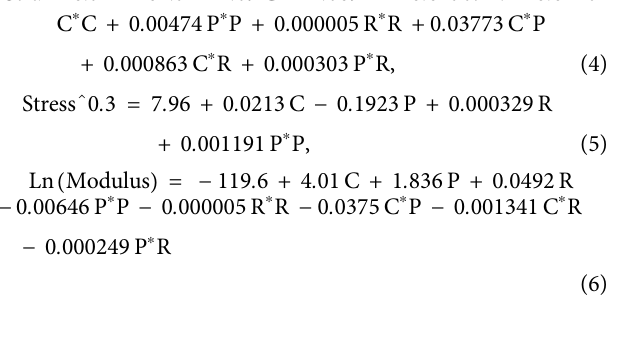
Frontiers in Bioengineering and Biotechnology |